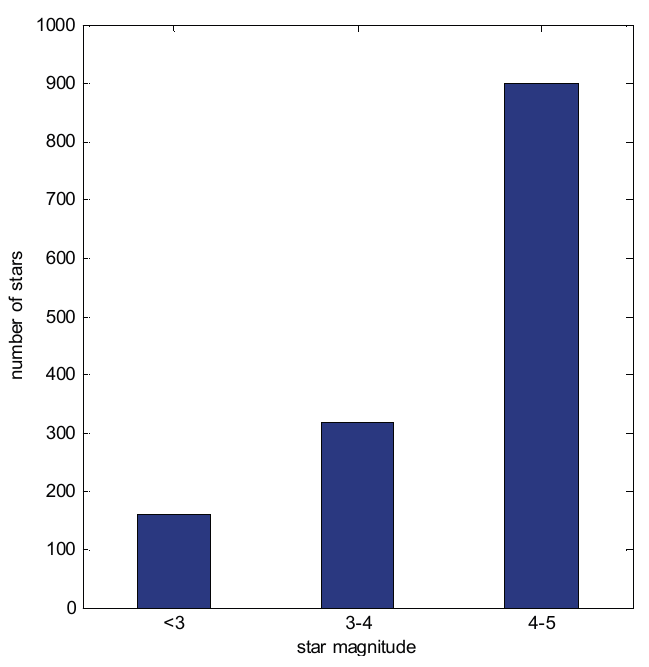
Figure 7. Brightness of simulated stars.